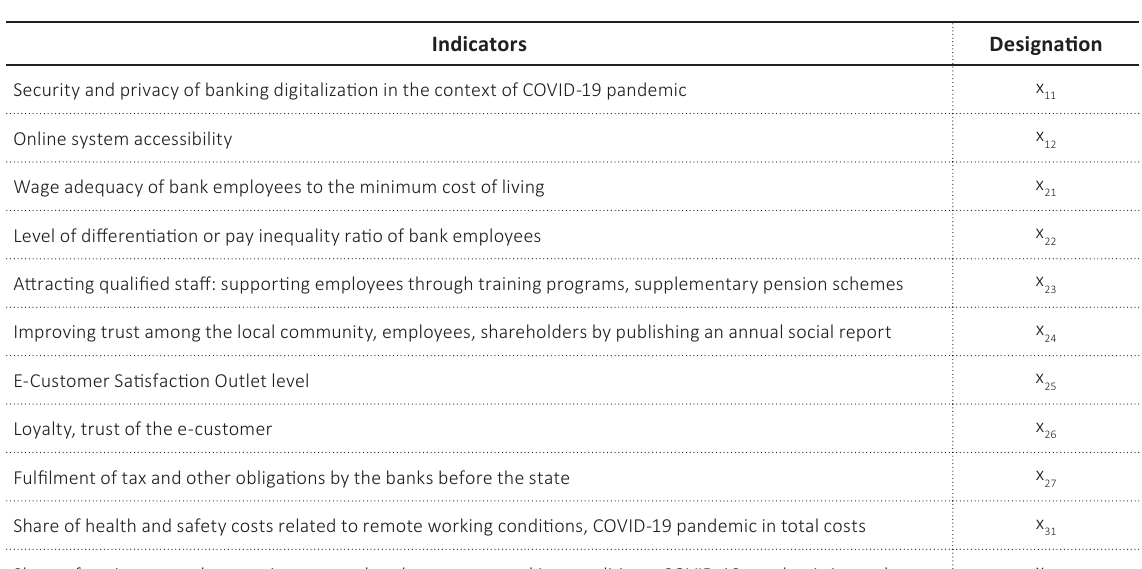
Table 2. Initial data to build a model for banking digitalization in the context of the COVID-19 pandemic based on CSR principles